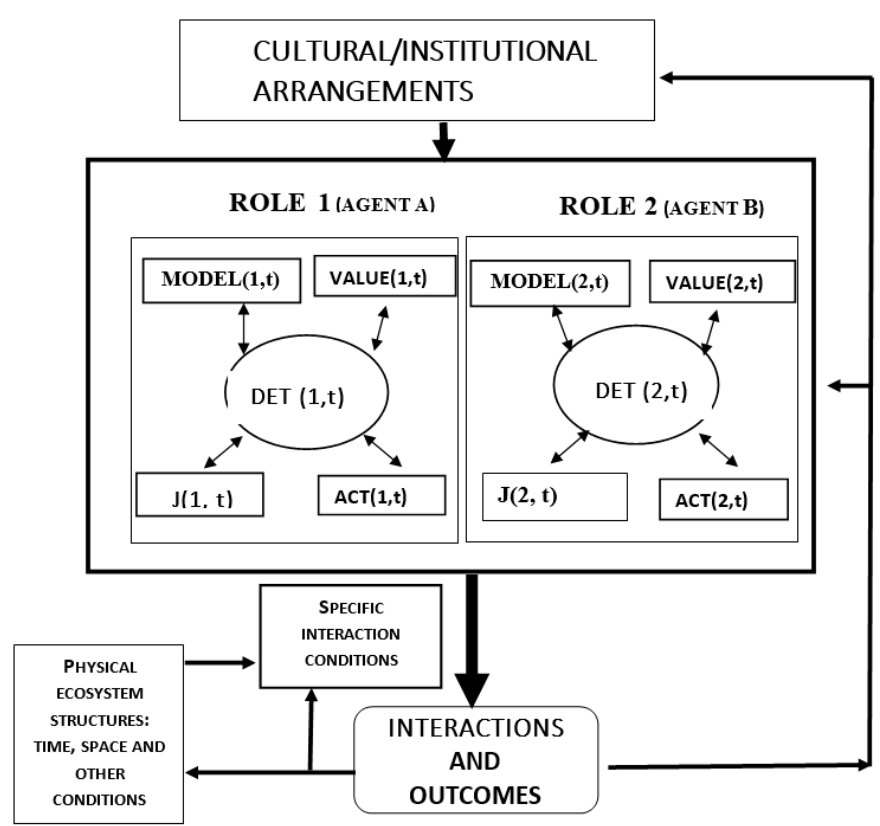
Figure 1. Two Role Model of Interaction Embedded in Cultural-Institutional and Natural Contexts.